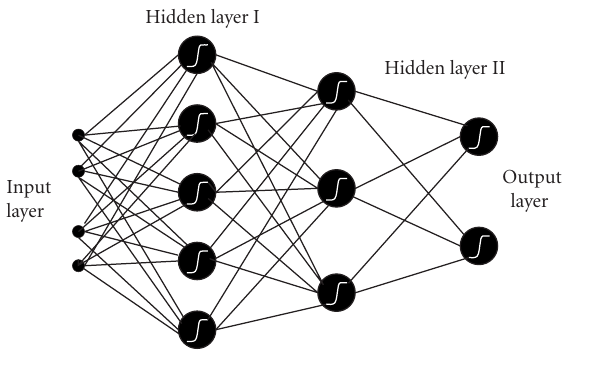
Figure 1: A simple multilayer perceptron. Average of minimum MSEs with standard deviation